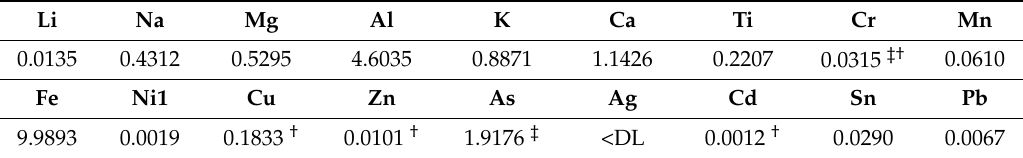
Table 1. Volume, bulk density, paste pH, TOC, and TIC data for the composite mine tailings sample along with the total mass of the tailing piles. Table 2. Notable metal and metalloid concentration data (wt %) for composite samples from all sites † indicates concentrations above screening levels for ecological risk (1); ‡ indicates those above guideline levels for human health risk (2,3).